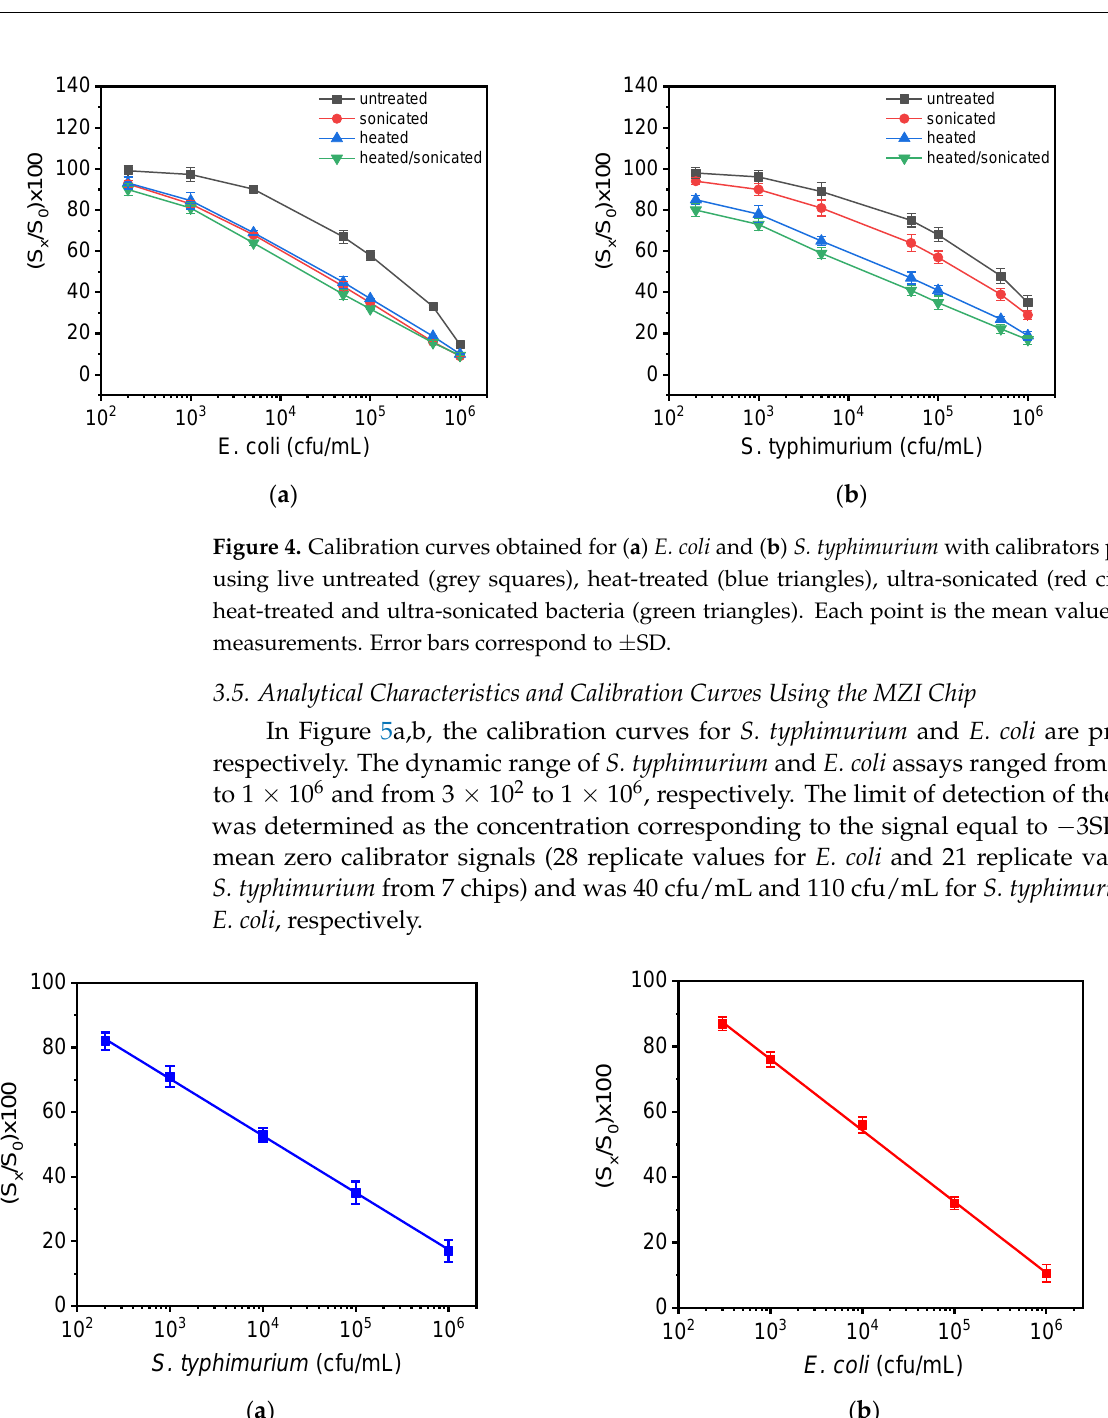
Figure 5. Calibration curves of ( a ) S. typhimurium and ( b ) E. coli . (S x /S 0 ) × 100 represents the percent ratio of each calibrator signal (S x ) to the zero calibrator signal (S 0 ). Each point is the mean value of three chips ±SD.